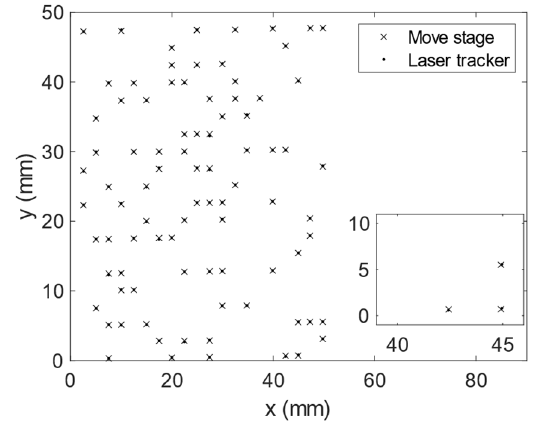
Figure 9. Calibration using IT2FLS for testing data. Table 2. XY-mean absolute error and standard deviations of error for the linear stage.